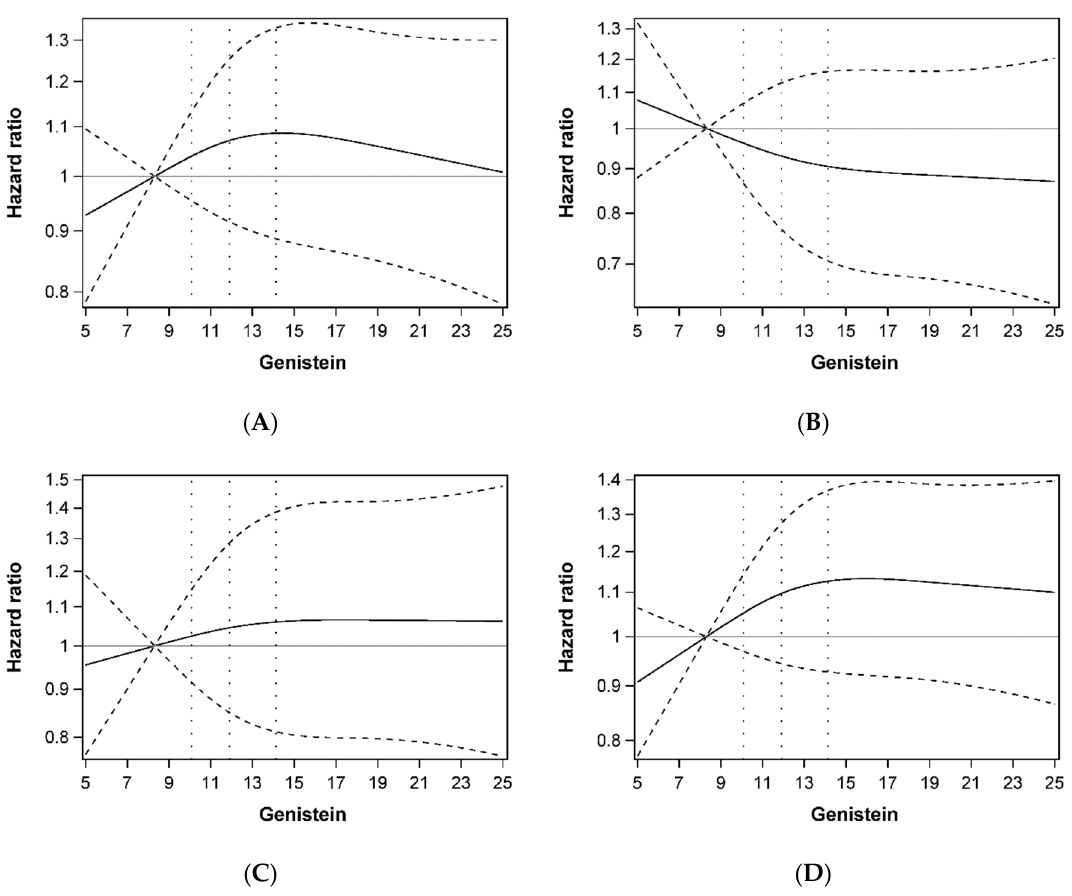
Figure 1. Dose-response relationship plots of the association between genistein concentration (ng/mL) and overall mortality ( A ), colorectal cancer specific mortality ( B ), colorectal cancer recurrence ( C ), and disease-free survival ( D ). Hazard ratios were estimated using restricted cubic-spline proportional hazard models with three knots placed at the 10th, 50th, and 90th percentiles of genistein concentration. The 10th percentile of genistein concentration was treated as the reference level, and 25th, 50th, and 75th percentile were shown as dashed vertical